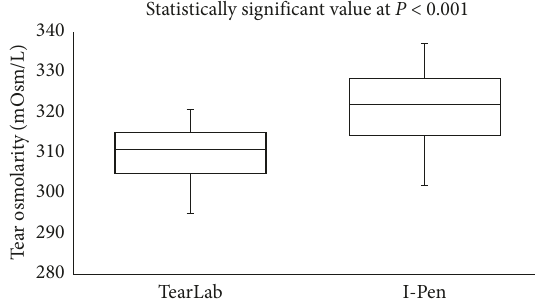
Figure 4: Side-by-side boxplot for tear osmolarity measurements using the TearLab and I-Pen systems in the study (smokers) group.